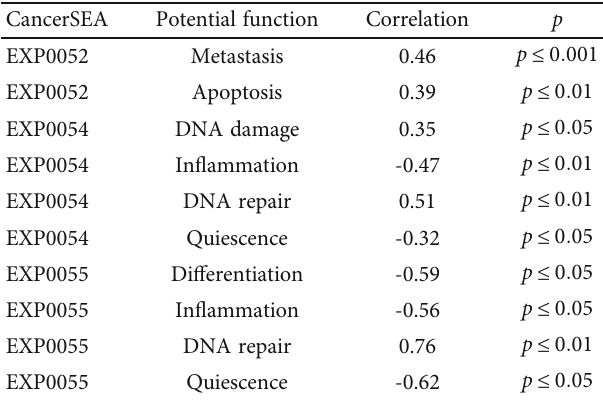
Table 2: Analysis of the potential functions of LMAN2 based on CancerSEA database.